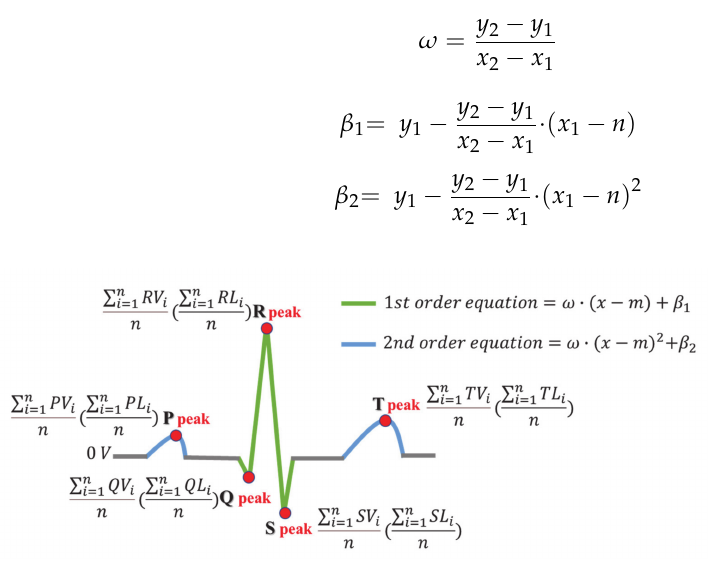
Figure 6. Generated ideal ECG one cycle.